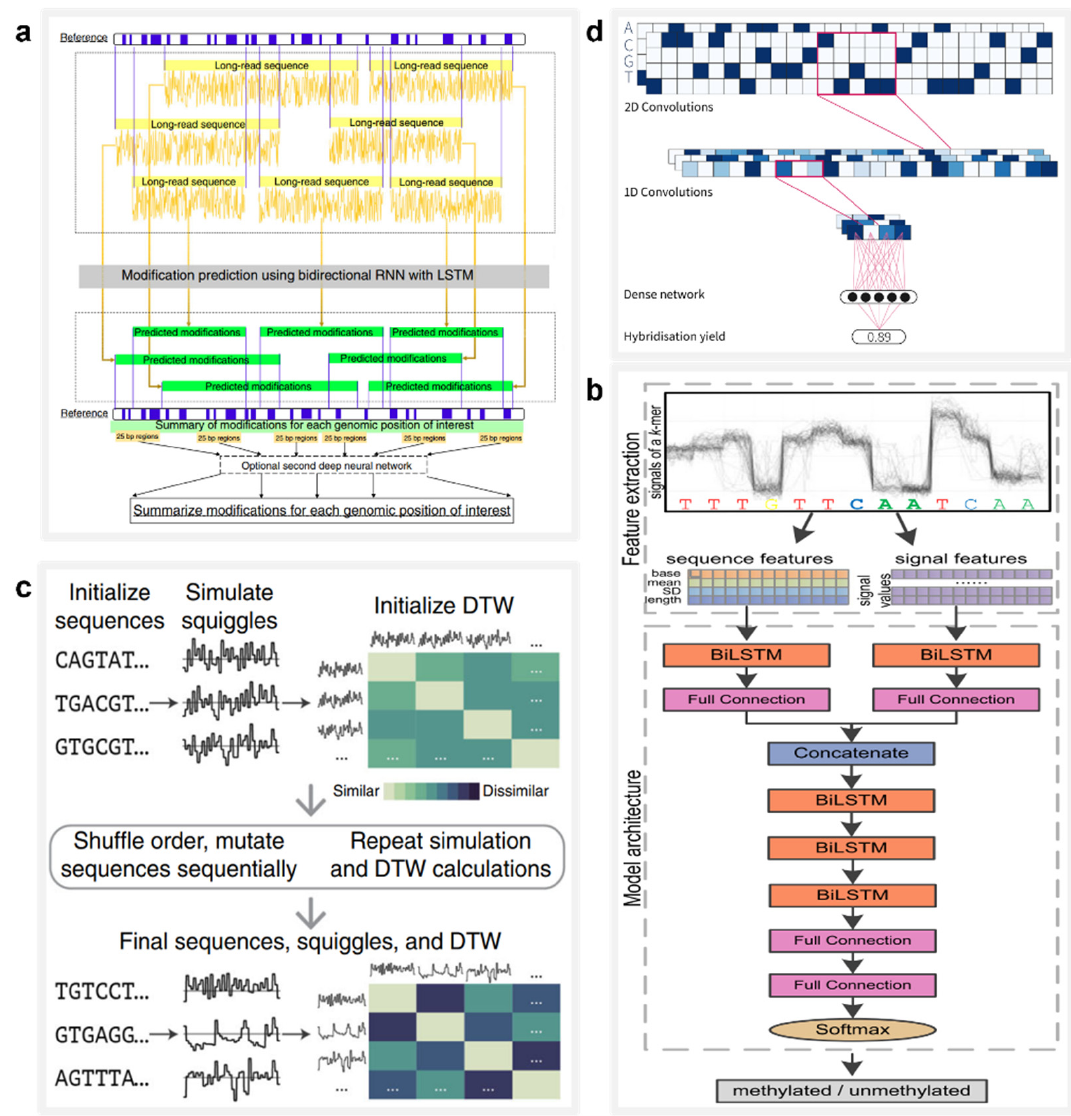
Figure 4. The applications of AI in DNA information storage. ( a ) Architecture of the neural network model DeepMod, which is used to capture the time-series characteristics of nanopore signals and detect DNA modifications. Reprinted from [117]. ( b ) Architecture of DeepSignal-plant, in which sequence and signal features can be extracted using bidirectional LSTM (biLSTM). Reprinted from [118]. ( c ) Evolutionary model workflow for hybrid prediction DNA coding. Reprinted from [120]. ( d ) Schematic diagram of CNNs used to quickly read molecular labels. Reprinted from [121].